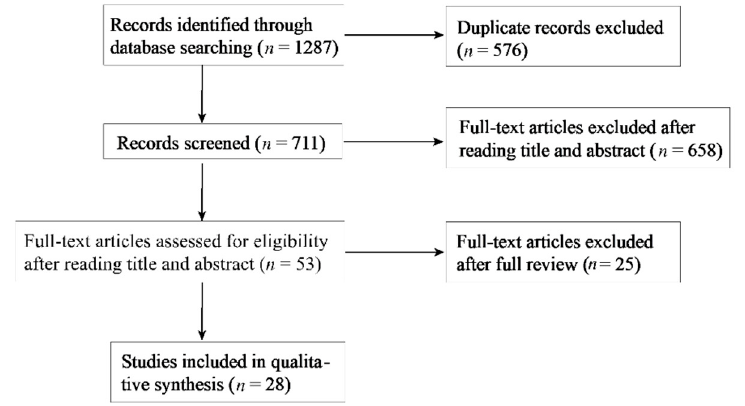
Figure 1. Flowchart of the search